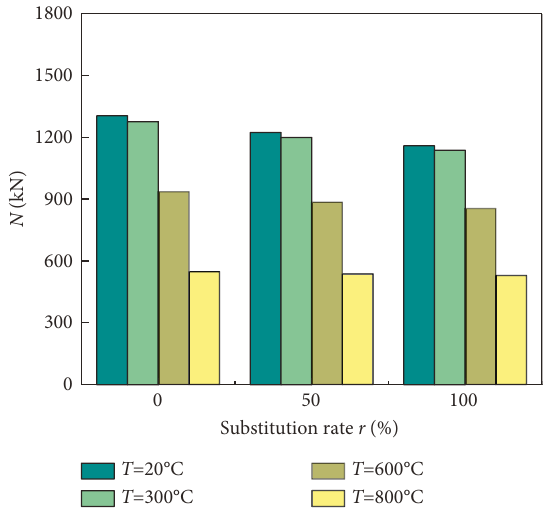
Figure 7: Influence of temperature on ultimate bearing capacity.